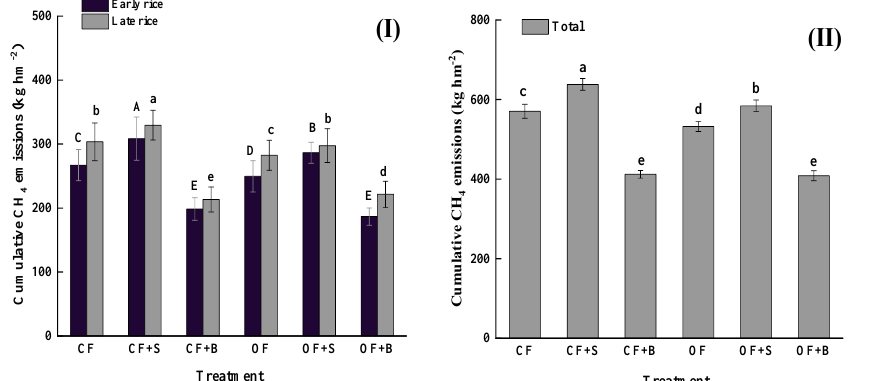
Figure 2. Cumulative CH 4 emissions of early rice/late rice ( I ) and the total ( II ) in the double rice cropping system under different treatments. Error bars represent standard deviations ( n = 3). Uppercase and lowercase letters indicate significant differences at the 0.05 level between treatments in early and late rice seasons.